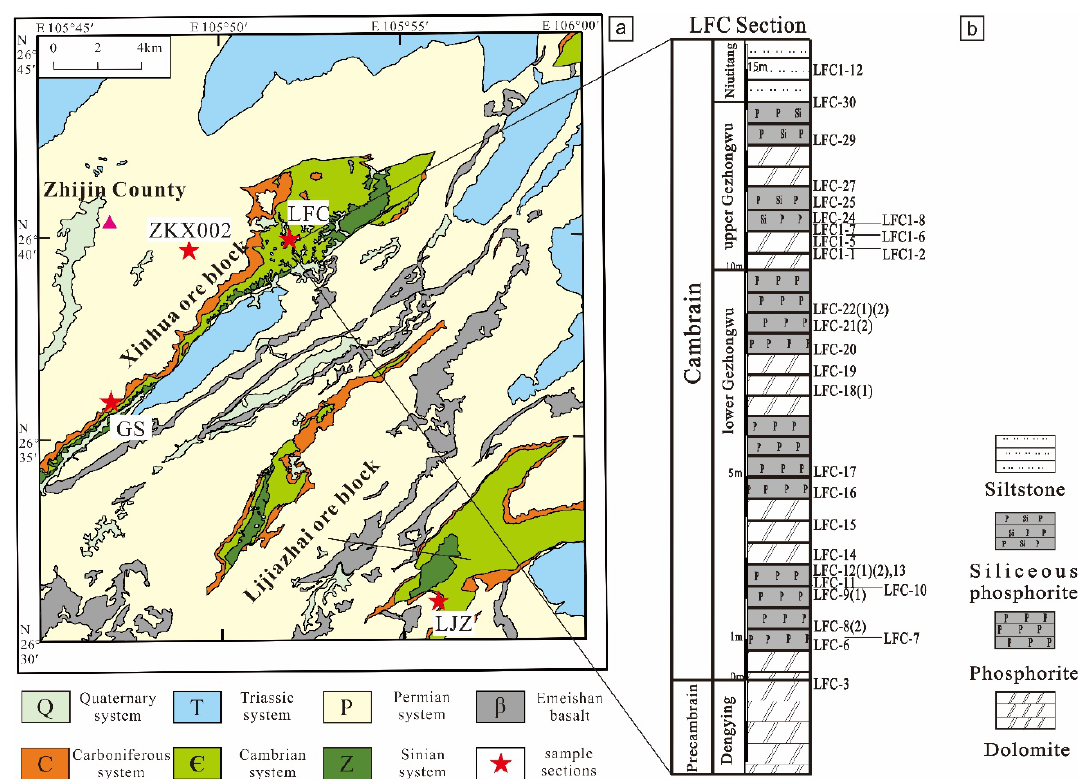
Figure 2. ( a ) Geological map of the Zhijin region. The pink triangle represents Zhijin County, and the red stars are the sampling locations (LFC is the Linfeichang section; Gs is the Gaoshan section; LJZ is the Lijiazhai section.). ( b ) Stratigraphic columns and sampling sites of the LFC Section.